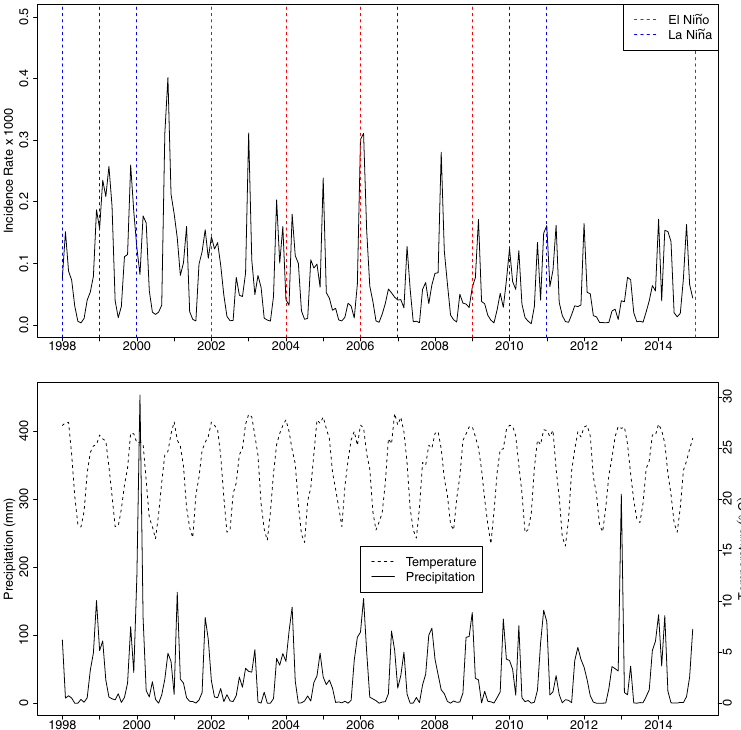
Figure 2. Time series of ( a ) malaria incidence rate (% per 1000 person-years), ( b ) precipitation (solid line, mm month − 1 ), and mean temperature (dashed line, °C) by month for Limpopo from 1998 to 2014. Years are labeled with El Niño (red lines) and La Niña (blue lines) events. Figure was made in R version 3.2.2 (https://cran.r-